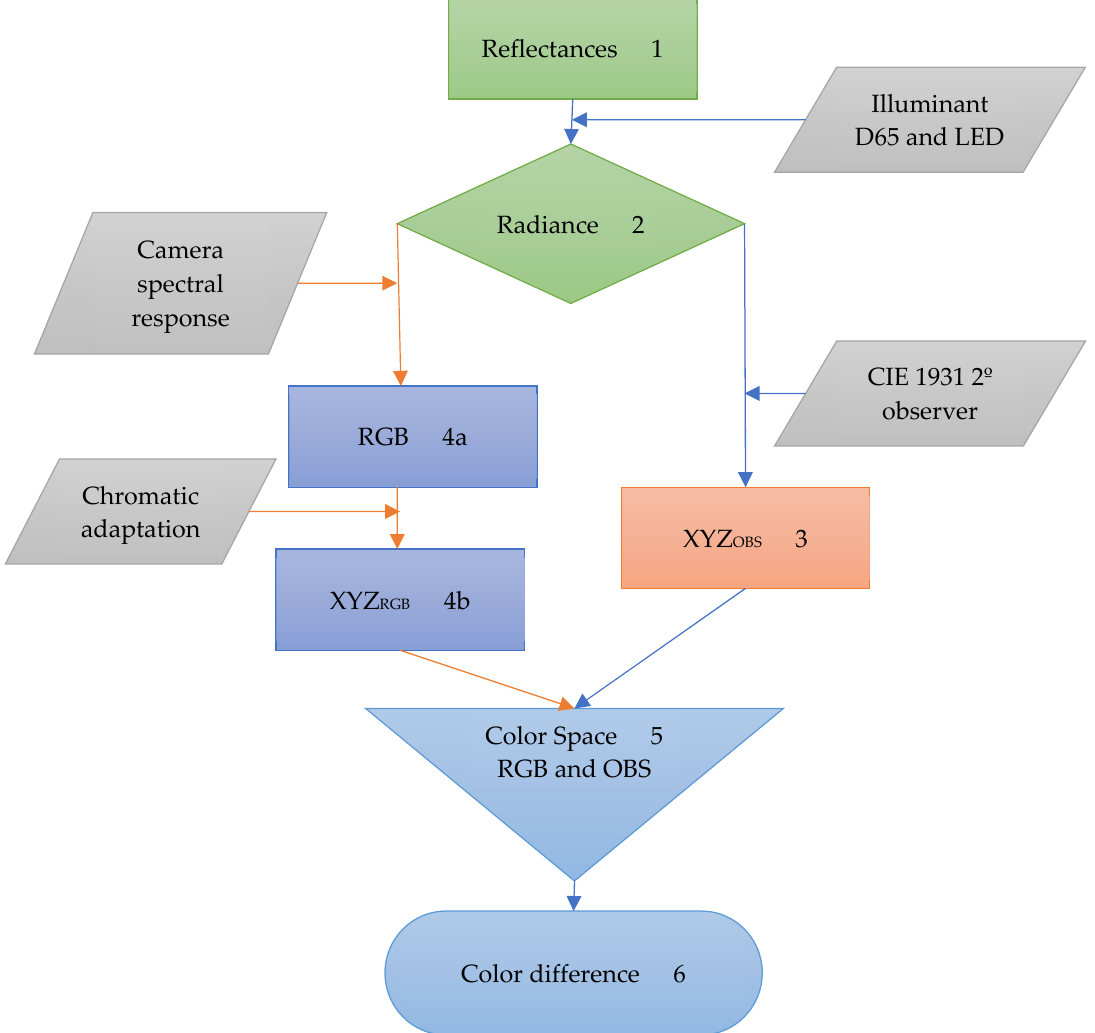
Figure 1. Workflow used to estimate the color differences between the human eye and a RGB digital camera. From a set of reflectance functions derived from spectral imaging (1), the colors processed by the digital camera (4, orange lines) and those seen by the standard observer (3, blue lines) were estimated and compared in the same color space (5 and 6).